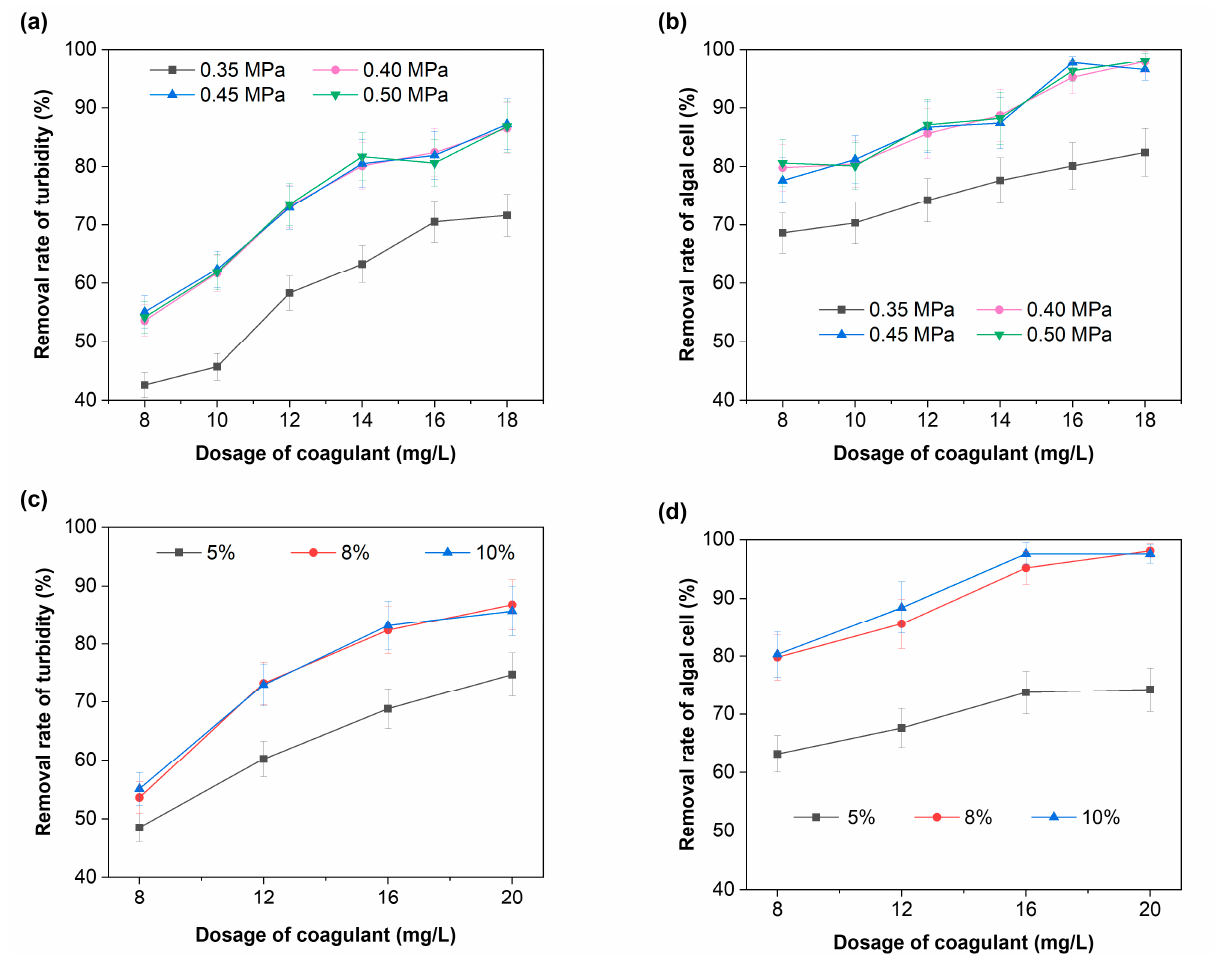
Figure 4. Impact of the pressure of the dissolved air on the turbidity removal rate ( a ) and algal cell removal rate ( b ); and the impact of the reflux ratio on the turbidity removal rate ( c ) and algal cell removal rate ( d ).